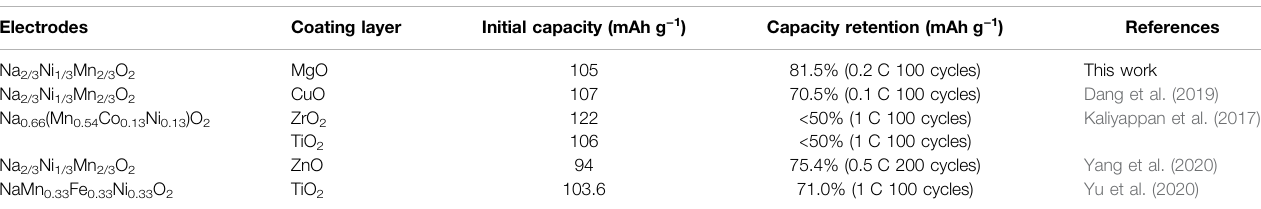
TABLE 1 | Comparison of initial capacity and cycling stability of layer cathodes modi fi ed by coating in recent